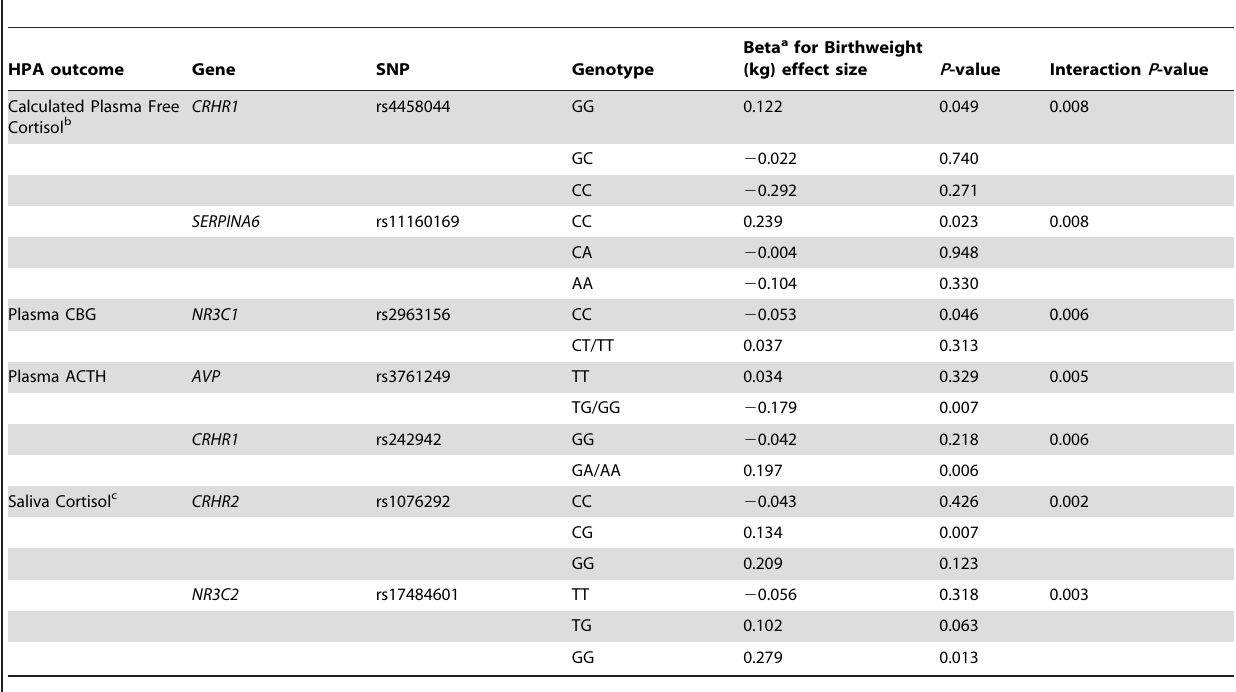
Table 5. The association between birthweight and log transformed saliva and plasma HPA outcomes stratified by genotype for the most significant SNP*birthweight interactions (p , 0.01).